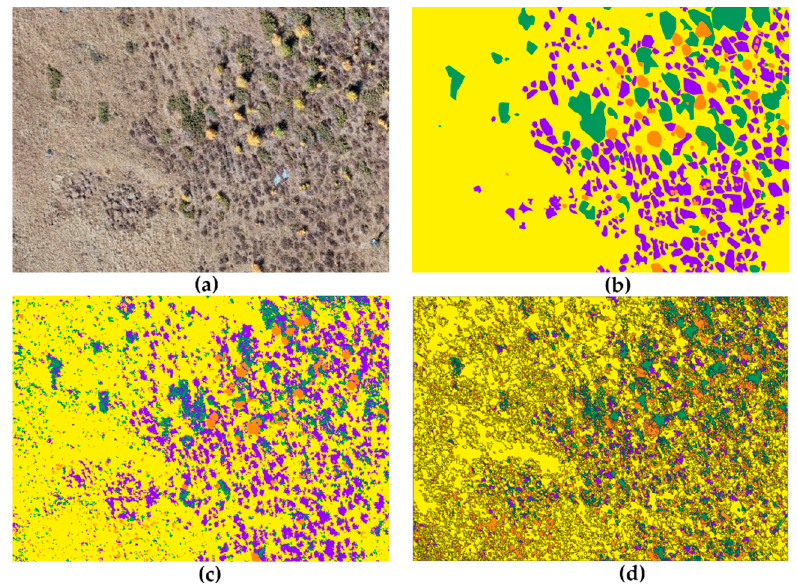
Figure 6. Same portion of the original high-resolution (1 cm) image ( a ) and of the most accurate classification maps obtained through photo-interpretation ( b ), pixel-based classification ( c ) and object-based classification ( d ).